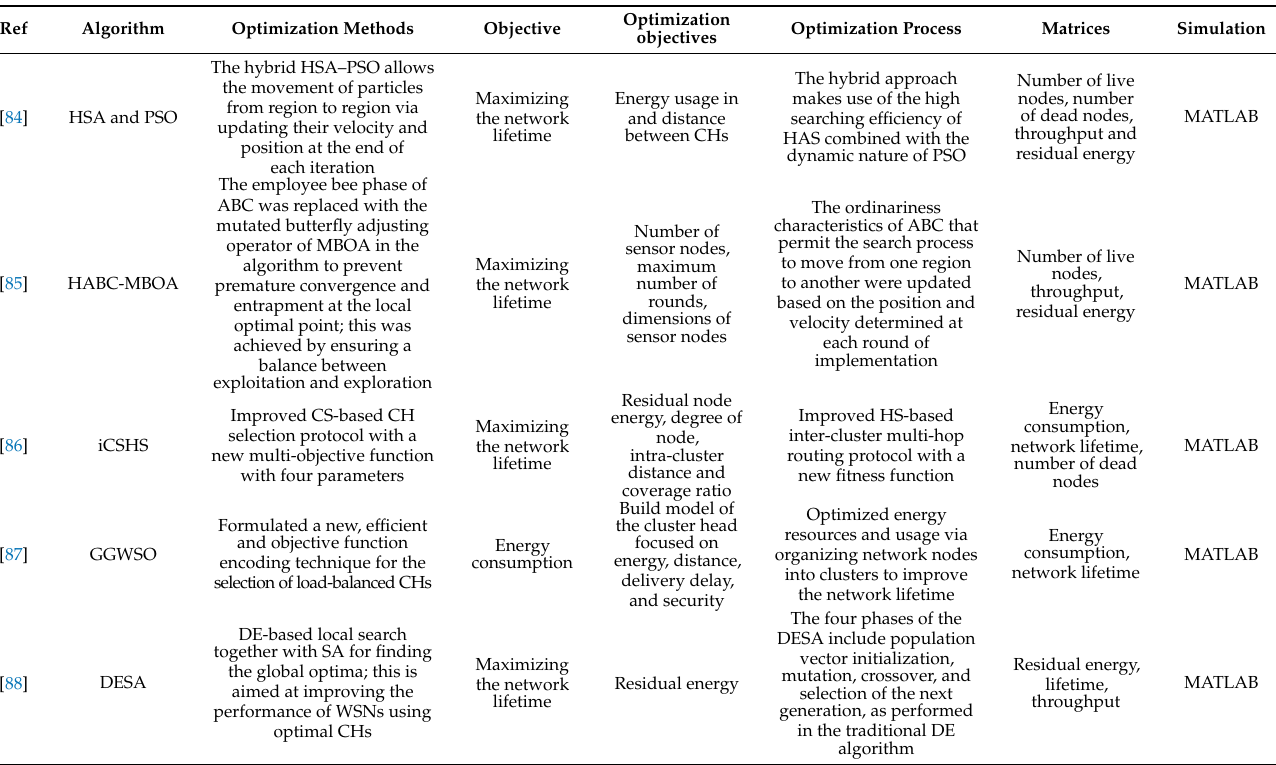
Table 6. Comparison of studies involving hybrid meta-heuristic